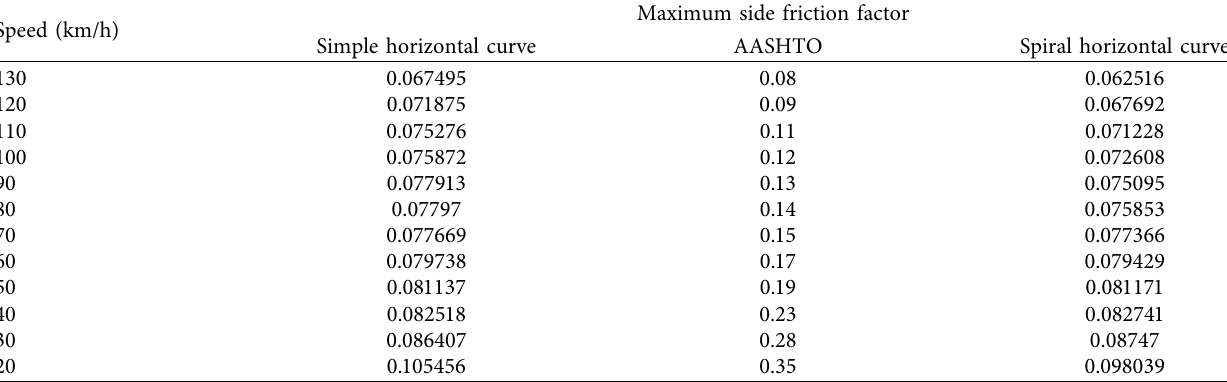
Table 10: Comparison of the maximum side friction factor for a truck between simple and spiral horizontal curves and AASHTO recommended values at a radius of 0.9R.